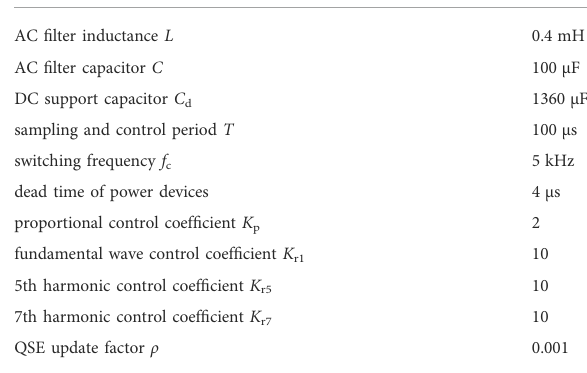
TABLE 1 Parameters of